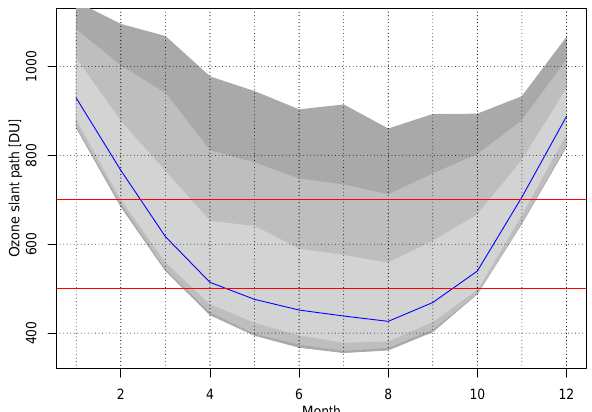
Figure 7. Seasonal cycle of the slant column over Arosa. The dif- ferent bands from dark gray to light gray encompass the respective SC limits of Q 97 . 5% − Q 2 . 5% , Q 90% − Q 10% and Q 75% − Q 25% . The blue line is for the monthly